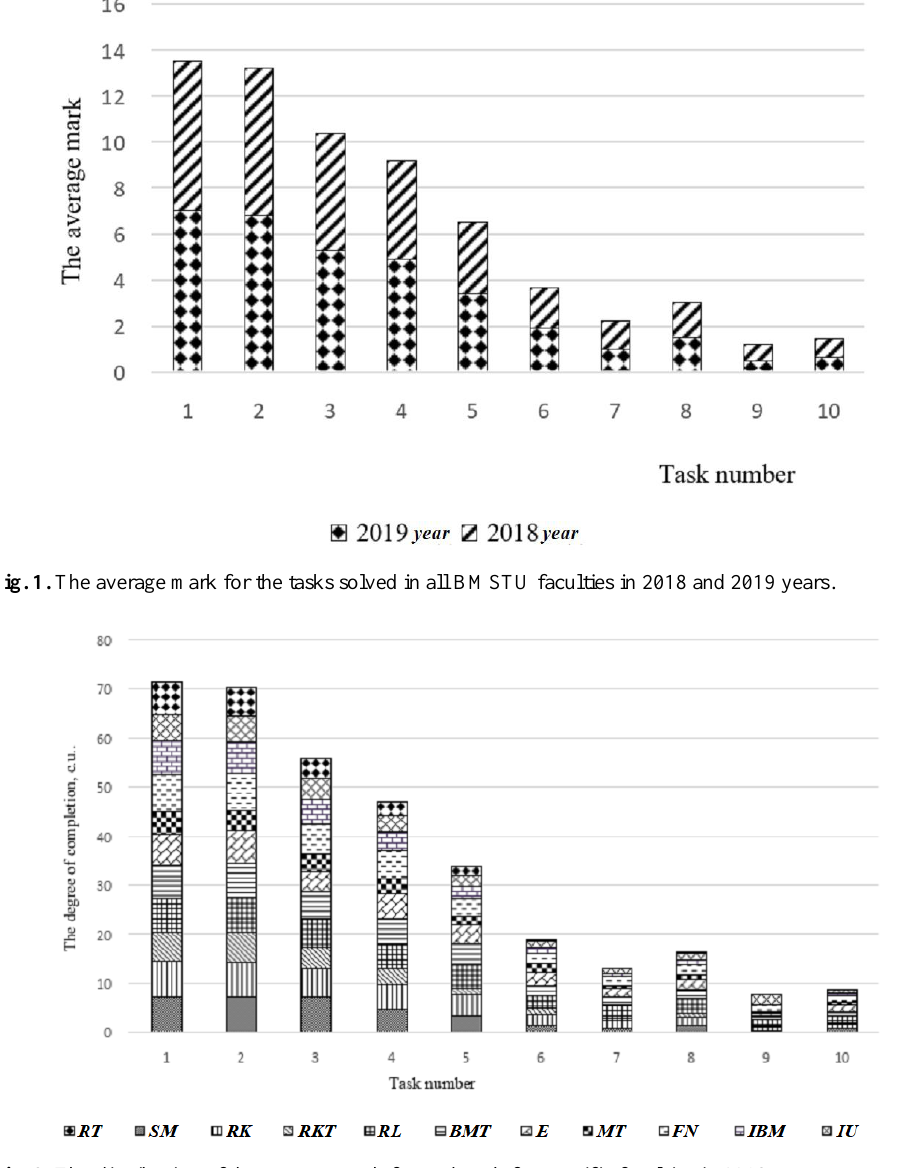
Fig. 2. The distribution of the average mark for each task for specific faculties in 2018